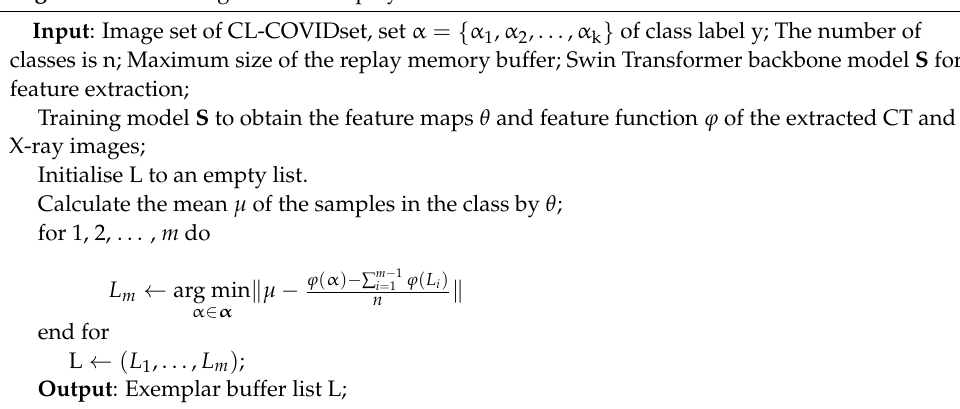
Algorithm 1: Herding Selection